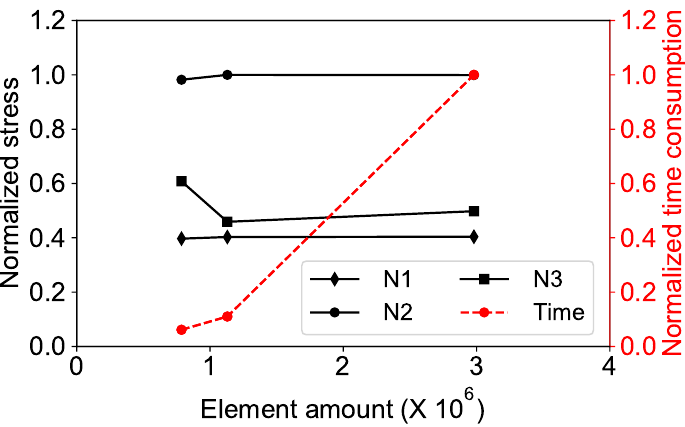
Figure 11. The mesh independence study of the flow-induced vibration